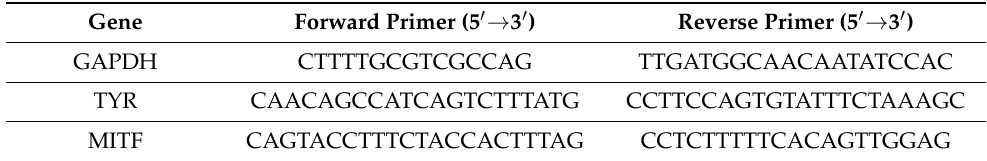
Table 1. Nucleotide sequences of primers used in RT-qPCR analysis.